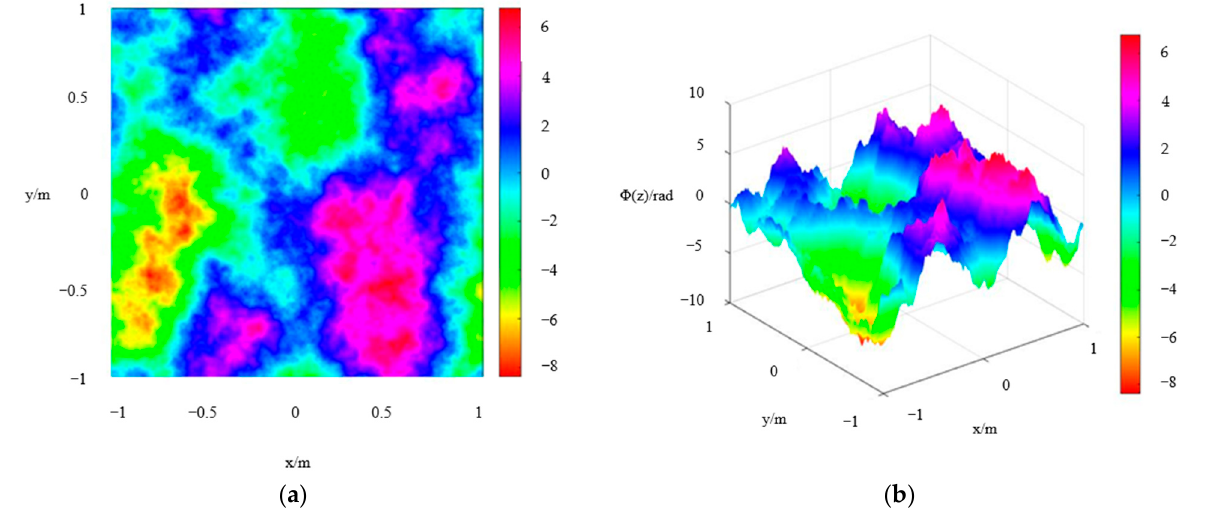
Figure 1. Simulated atmospheric turbulence phase screen. ( a ) Two-dimensional graph; ( b ) Three- dimensional graph.